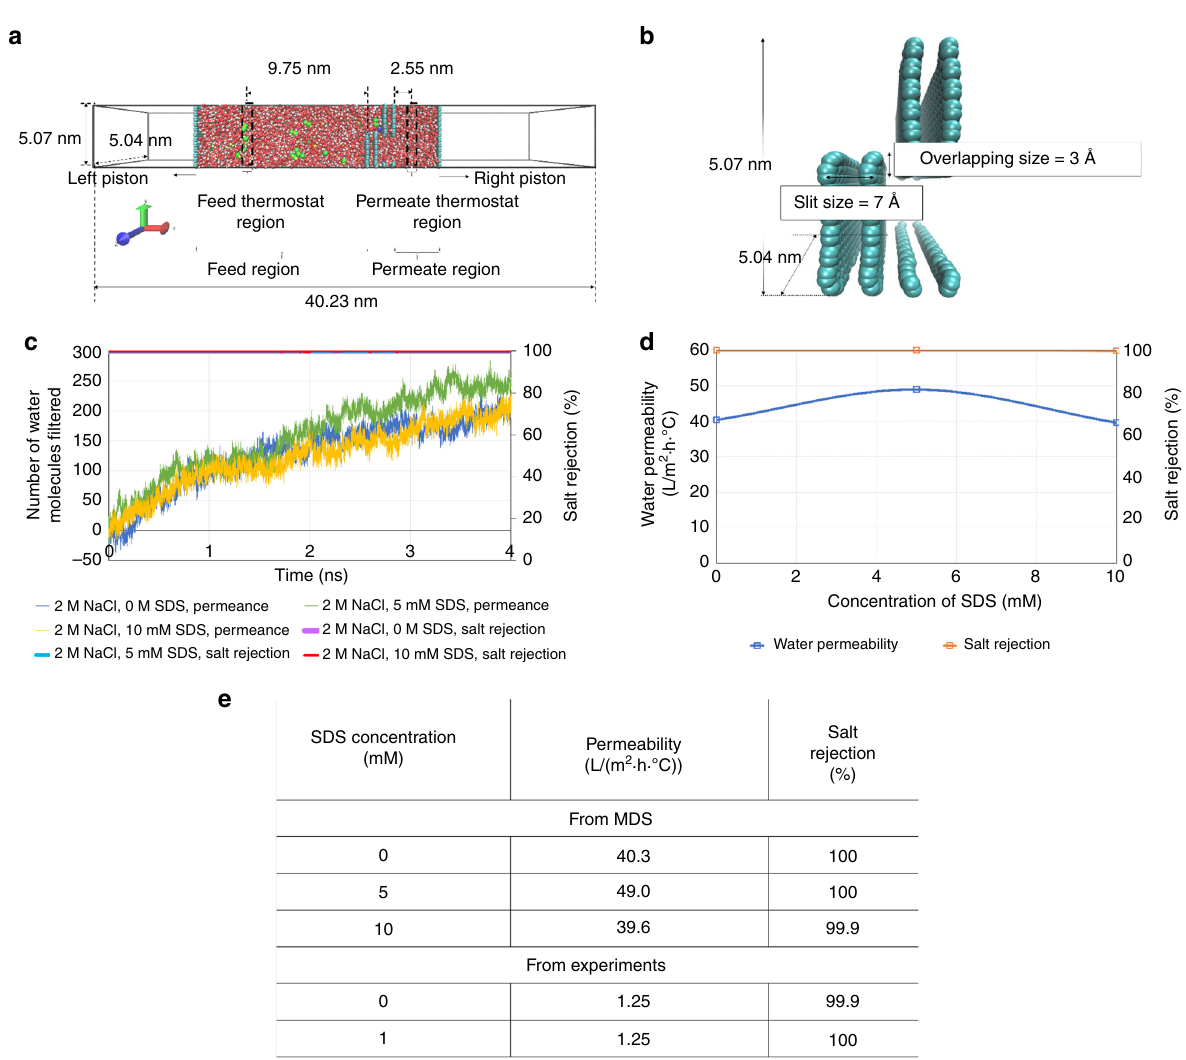
Fig. 8 Molecular dynamics simulation of water permeation through overlapping grain boundaries in graphene. The schematic ( a ) describes the simulation domain set up for the molecular dynamics study. b The molecular construct of the permeable graphene-based membrane, deduced from the characterisations (SEM, TEM, Raman spectroscopy and AFM) carried out on the membrane sample used for experimental testing. c The water permeation and salt rejection time history recorded during the molecular dynamics simulations. d The variation of water permeability and salt rejection with increasing concentration of SDS. e Comparison of numerical values of permeability obtained from MDS and from